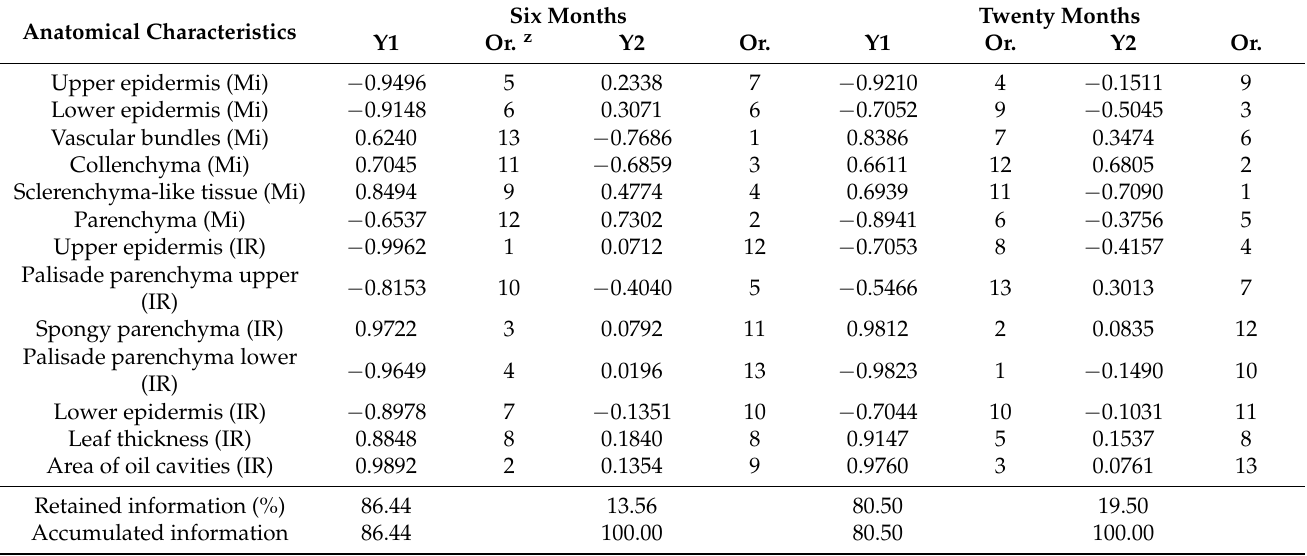
Table 5. Average period (days) of leaf differentiation of growth stages 1 to 3 and 1 to 5 of Eucalyptus grandis plants of 6 and 20 months old.